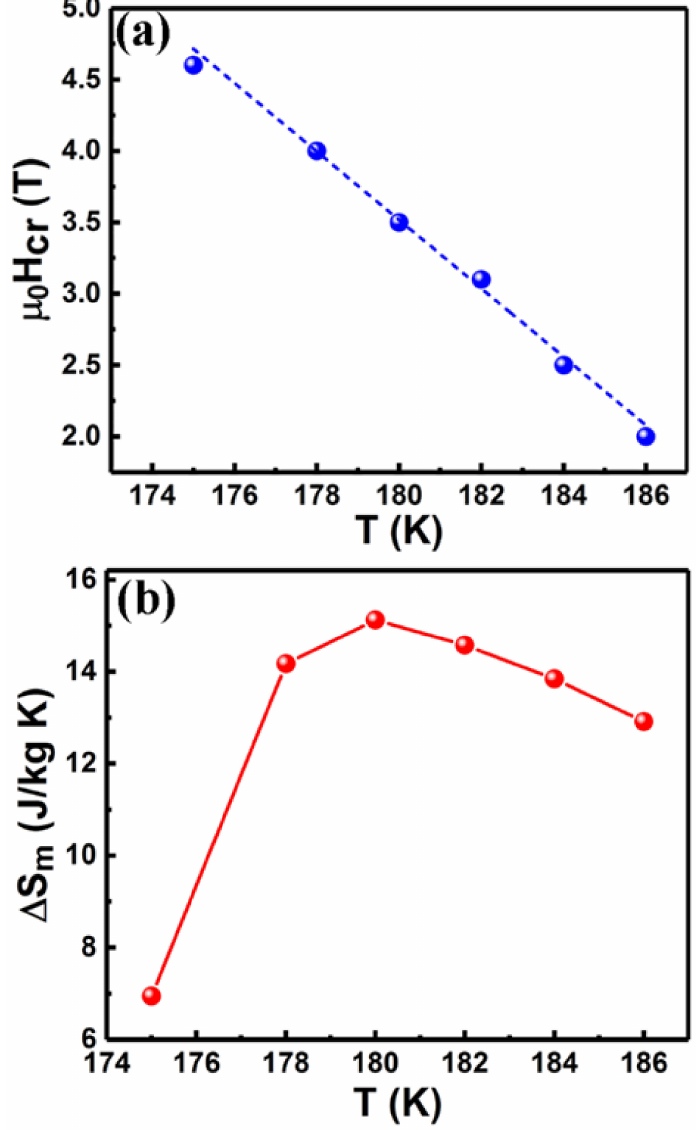
Figure 6. ( a ) Critical magnetic field for magnetic-field-induced phase transformation ( µ 0 H cr ) that was extracted from the M ( H ) curves in the second cycle in Figure 5b, shown as a function of temperature for the Ni 50 Mn 34 Fe 3 In 13 microwire. The dashed line represents the linear fitting of the data (denoted by symbols). ( b ) Reversible magnetic-field-induced entropy change ∆ S m as a function of temperature for the field change from 0.2 T to 5 T for the Ni 50 Mn 34 Fe 3 In 13